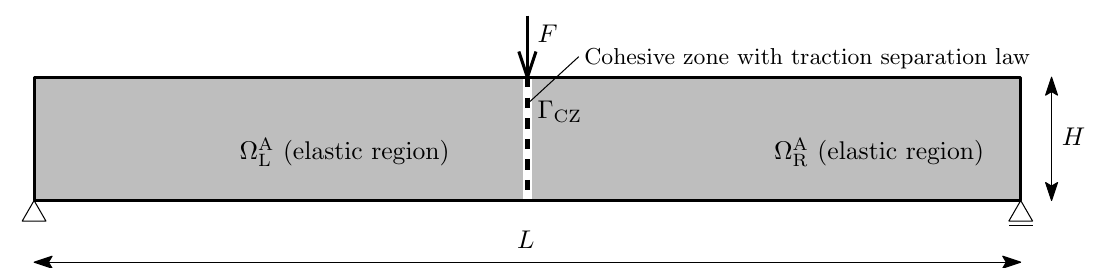
Figure 2. Geometry and boundary conditions of the finite element cohesive zone model (FE-CZ) subjected to a three-point bending test: elastic domain (grey) and cohesive zone (dashed line).